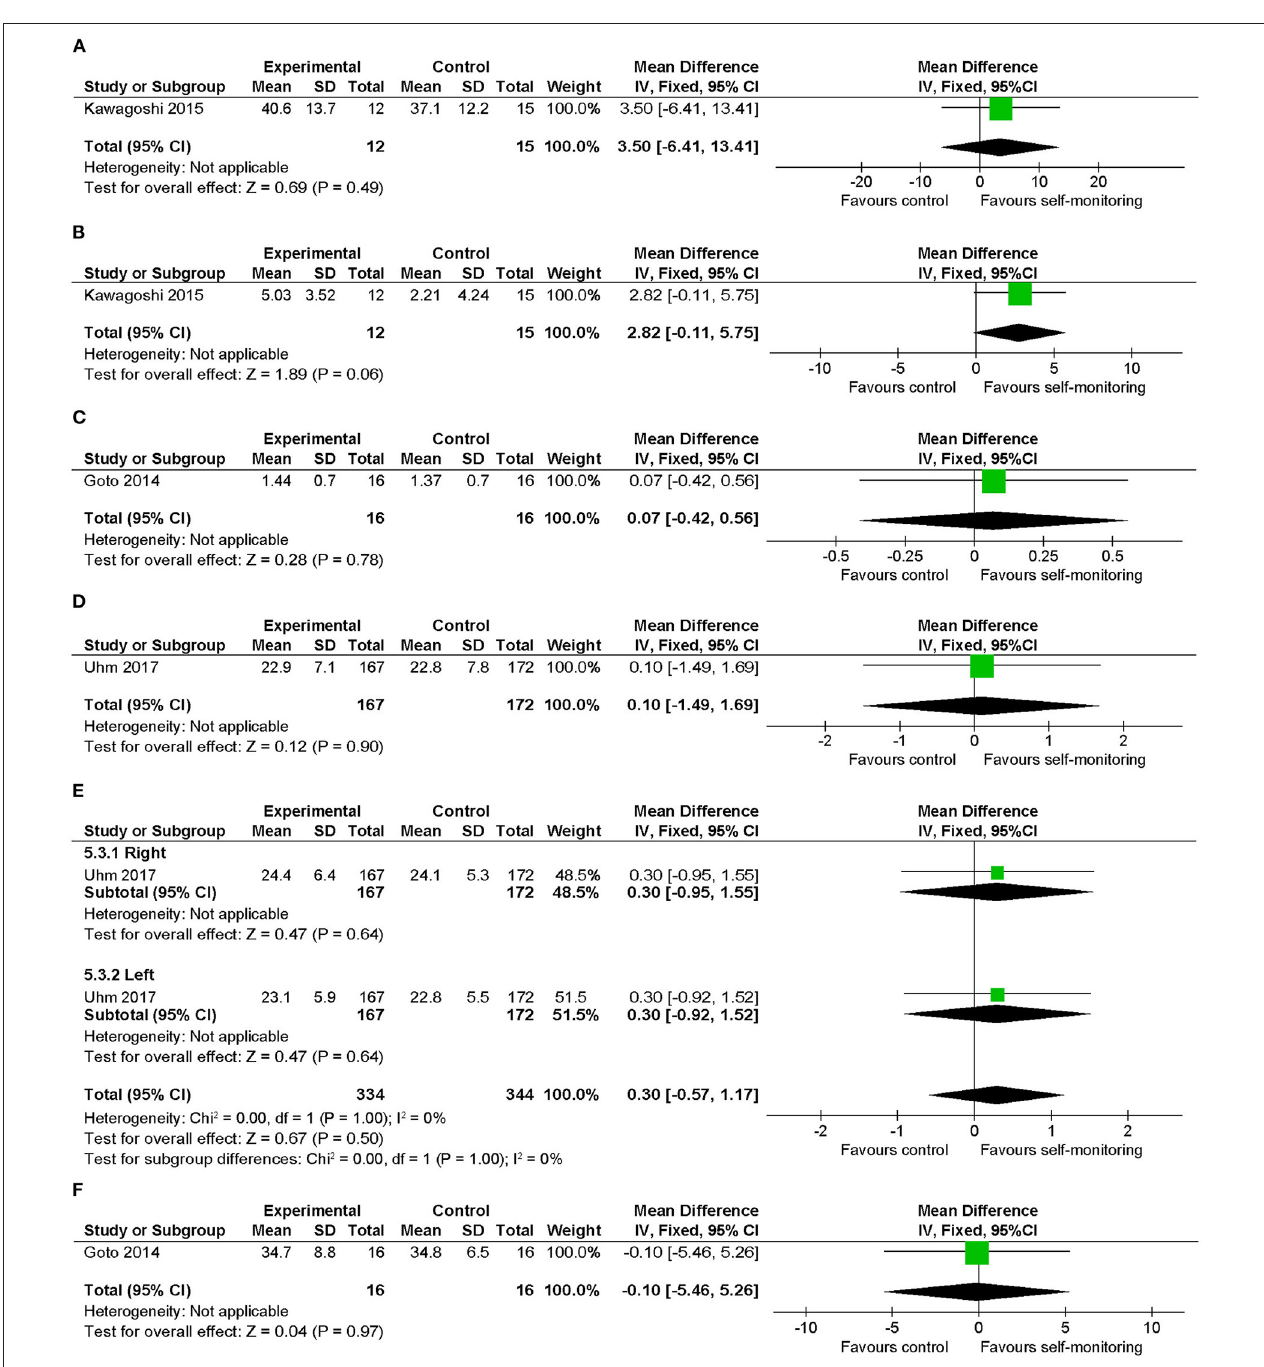
FIGURE 10 | Comparison of physical functions related to walking ability (secondary outcomes of interest) (17). (A) Knee muscle strength (kg) post intervention in patients with stable COPD, (B) knee muscle strength (kg) change from baseline in patients with stable COPD, (C) knee muscle strength (kg) post intervention in patients with hemophilia, (D) 30-s chair-stand test (no.) post intervention in patients with cancer, (E) handgrip strength (kg) post intervention in cancer, (F) Modified Functional Reach Test (cm) post intervention in patients with hemophilia. SD, standard deviation; IV, inverse variance method; CI, confidence